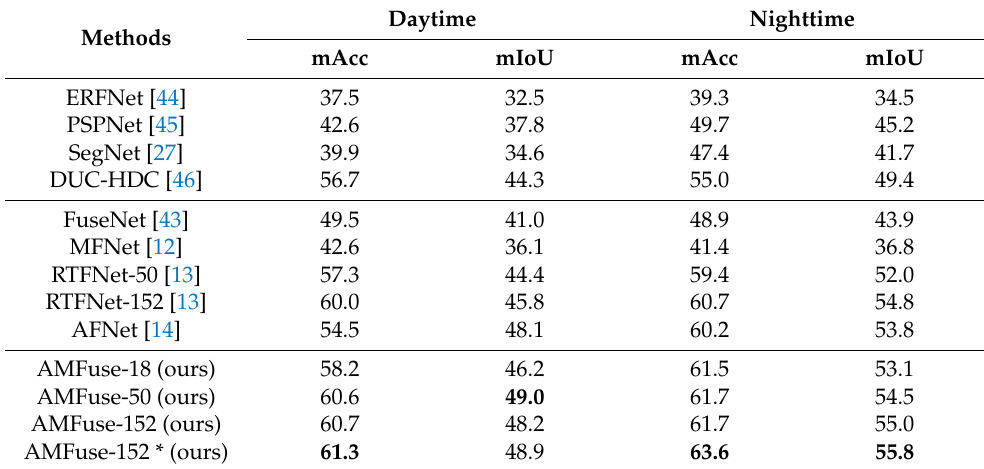
Table 2. The comparative results (%) on the daytime and nighttime scenarios. * denotes adding a 1 × 1 convolution layer for the multiplication operation in the AMFuse++ module.